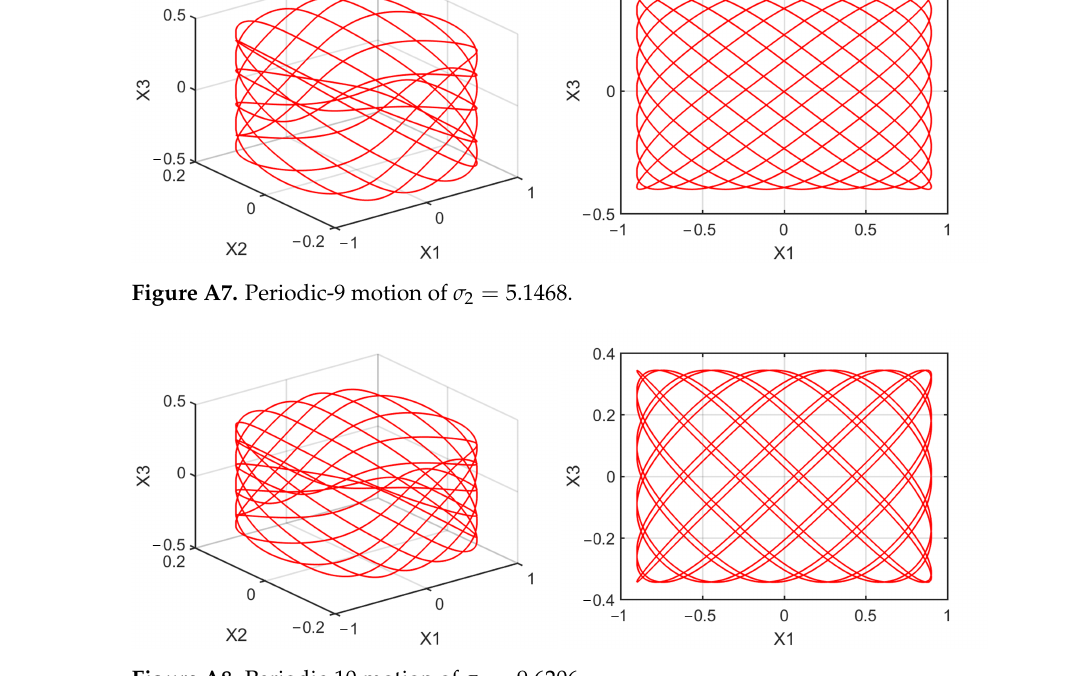
Figure A8. Periodic-10 motion of σ 2 = 9.6206.